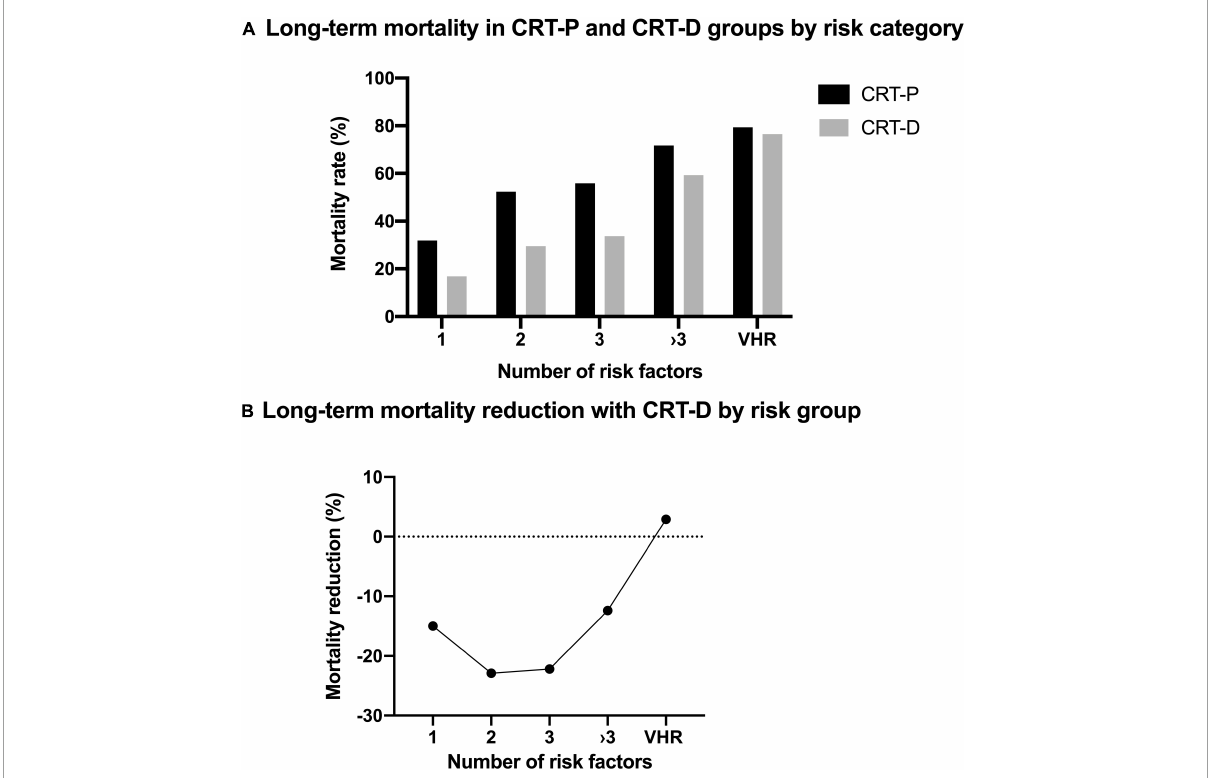
FIGURE1 (A) Long-term mortality in cardiac resynchronization therapy-pacemaker (CRT-P) and cardiac resynchronization therapy-defibrillator (CRT-D) groups by risk category. Higher long-term absolute mortality rates can be observed in patients with CRT-P devices compared to CRT-D nonetheless of their risk score, except in the very-high-risk (VHR) patient population. (B) U-shaped curve for implantable cardioverter defibrillator (ICD) efficacy. No significant effect of CRT-D implantation can be observed in high-risk (score ≥ 3) and VHR patients. The greatest mortality reduction can be seen in low-risk patients.